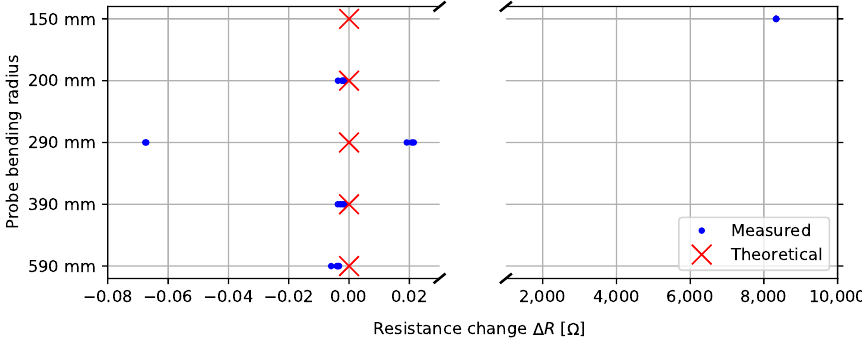
Figure 11. Trace resistance under